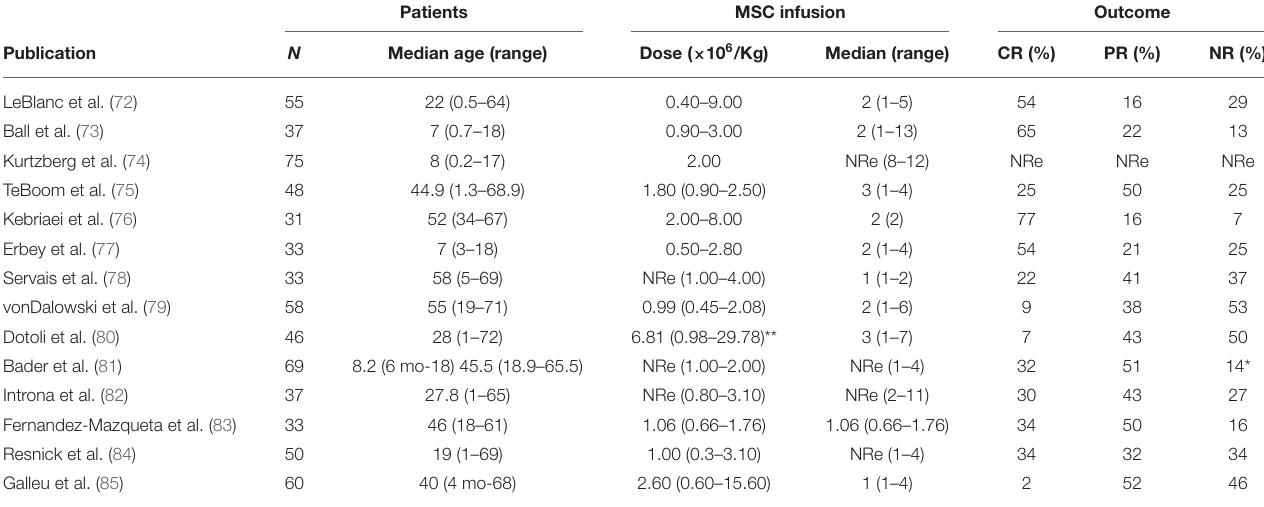
TABLE 1 | Clinical studies with MSCs used in aGvHD. Patients MSC